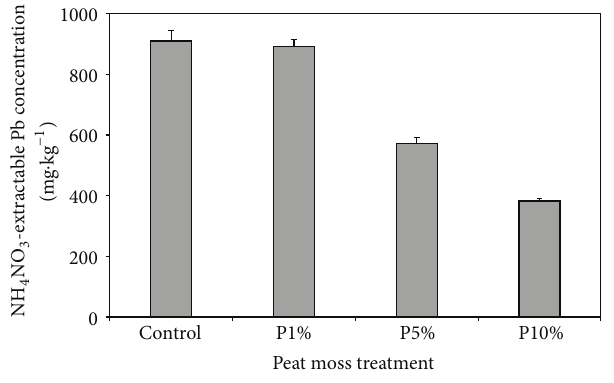
Figure 7: NH 4 NO 3 -extractable Pb concentration of Pb-contam- inated soils amended with peat moss (control: Pb-contaminated soil without peat moss, P1%: Pb-contaminated soil with 1% peat moss, P5%: Pb-contaminated soil with 5% peat moss, and P10%: Pb- contaminated soil with 10% peat moss).